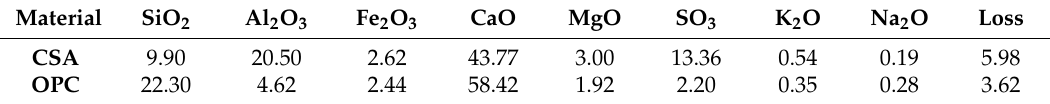
Table 1. Chemical composition of cementitious materials